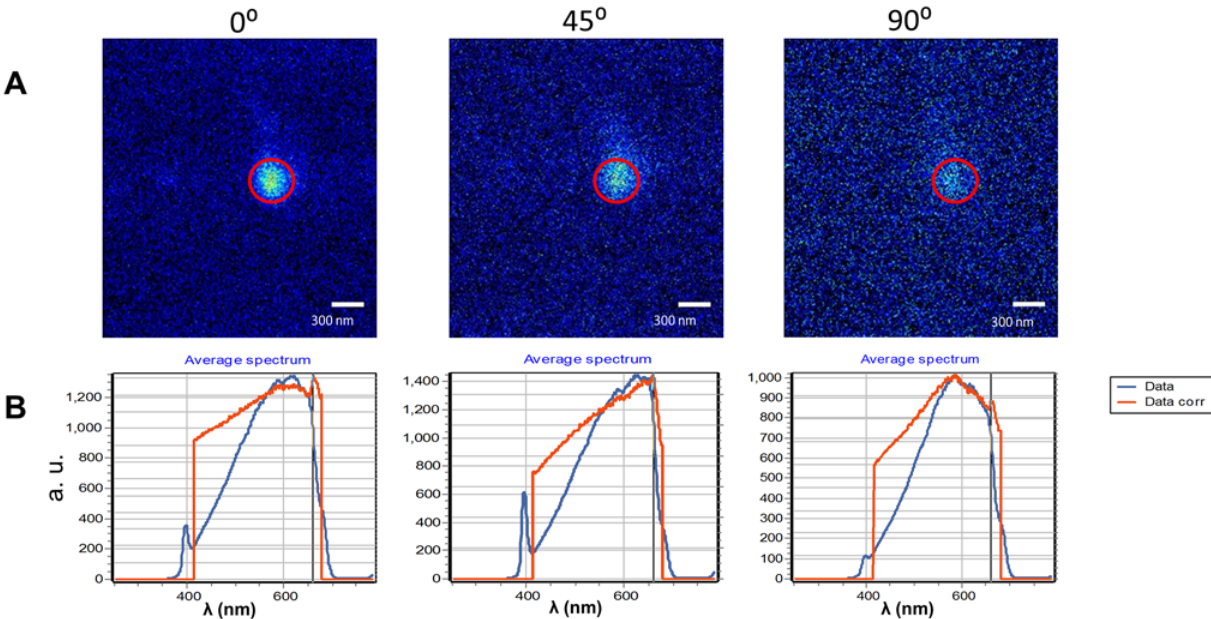
Fig 2. Raster scan images of a single gold nanoparticle fixed on a glass coverslip. (A)The sample is excited at 790 nm with 3 different orientations of linear polarized light. The emission is collected through a bandpass filter 520/30 nm. (B) Emission light collected with the spectral camera. The blue line in the spectrum is the raw data. The red line is the corrected intensity for the instrument response in the range 420 – 670 nm. Fig 2 shows 3 different polarization angles of excitation: 0°, 45° and 90°. The spectrum is characterized by a broad emission with a maximum around 600nm. The wavelength of the maximum is orientation dependent. There is a narrow feature at 395nm which is due to SHG.